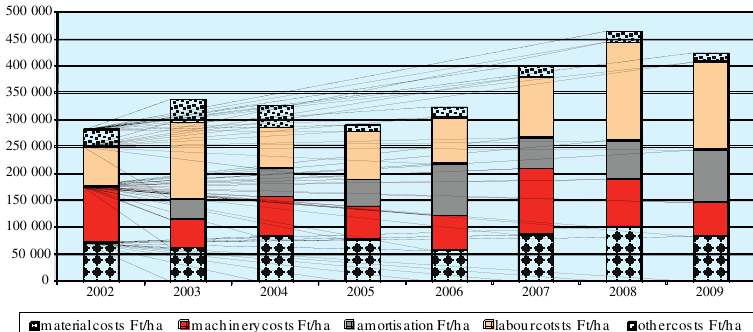
Figure 2. Direct costs of plum production in Hungary in farms relevant for the market